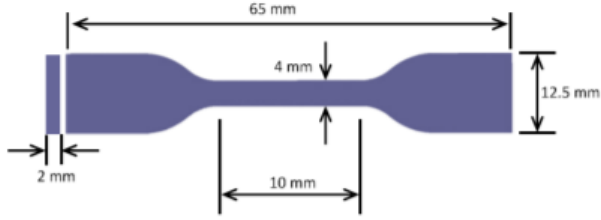
Figure 9. Dimensions of the Specimen.